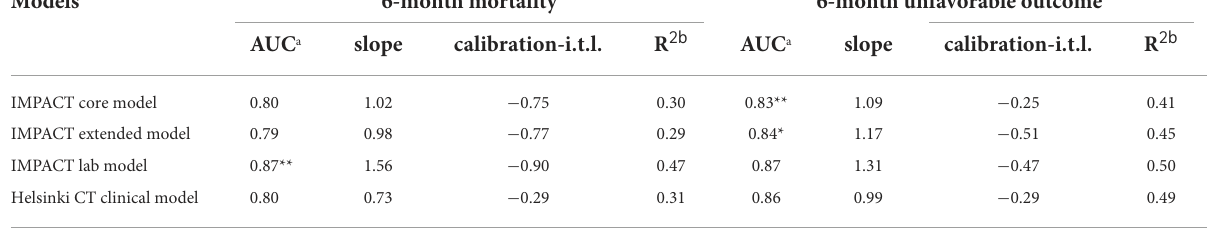
TABLE 4 Validation of IMPACT models and Helsinki CT clinical model for prediction of 6-month mortality and unfavorable outcome in PLANC cohort.